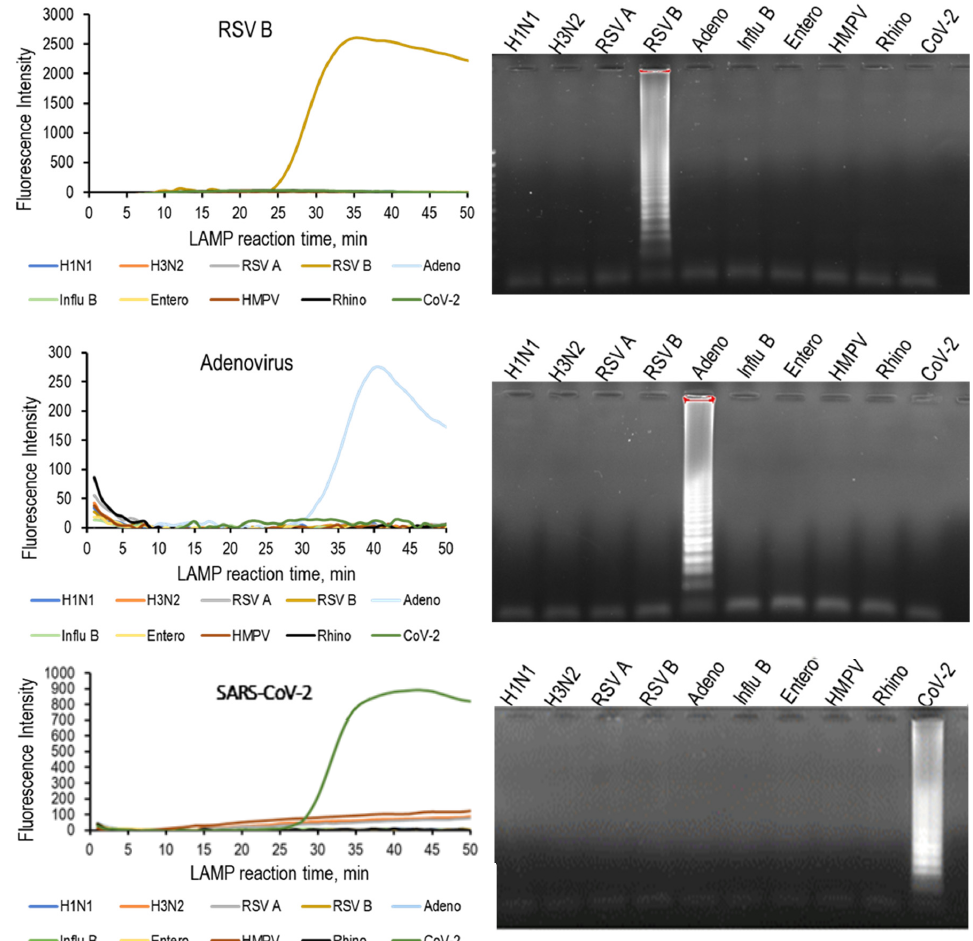
Figure 1. ( Left ) RT-qLAMP results and ( right ) agarose gel electrophoresis of RT-qLAMP products for the corresponding virus with RNA/DNA from standard strains of 10 respiratory viruses. Amplifi- cation was observed only for the respective standard strains and no cross-reactivity was served. RSV: respiratory syncytial virus, HMPV: human metapneumovirus, CoV-2: severe acute